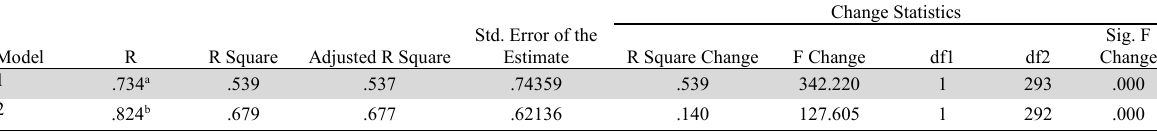
Model summary of the ACAP, DL and IP